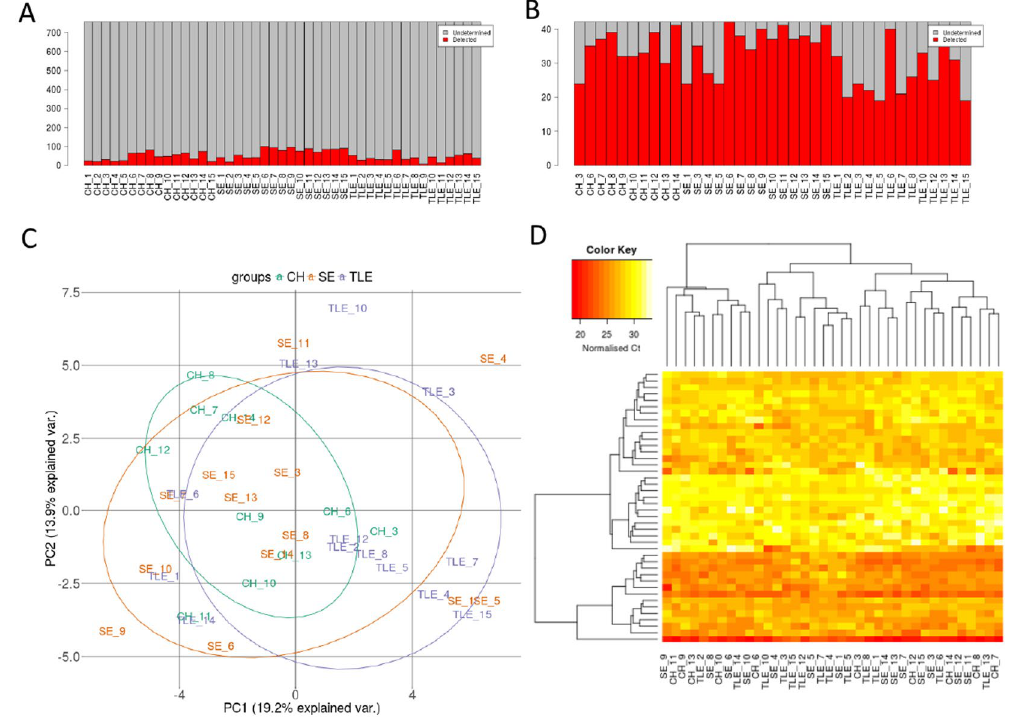
Figure 1. Bar plot showing the number of microRNA detected in each sample ( A ) before and ( B ) after filtering to remove any microRNA not present in at least 50% of samples. ( C ) Principal component analysis (PCA) plot. The PCA was performed on samples after imputing missing values, normalisation of Ct values and batch correction for sample origin. ( D ) Heat map and unsupervised two-way hierarchical clustering by sample and microRNA. Dendrograms were constructed using complete linkage method with Euclidean distance measure.